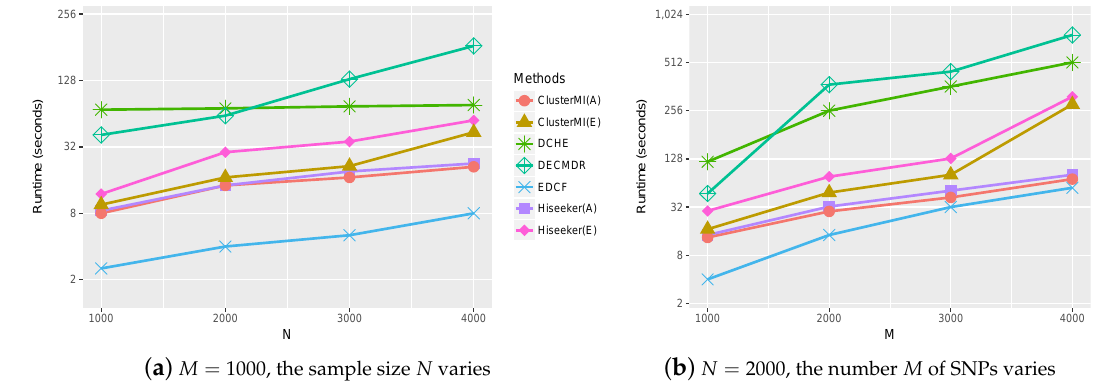
Figure 5. Runtime of different approaches on the simulated datasets. ( a ) The sample size N varies from 1000–4000 with the number of SNPs M = 1000; ( b ) the number of SNPs M varies from 1000–4000 with the sample size N =